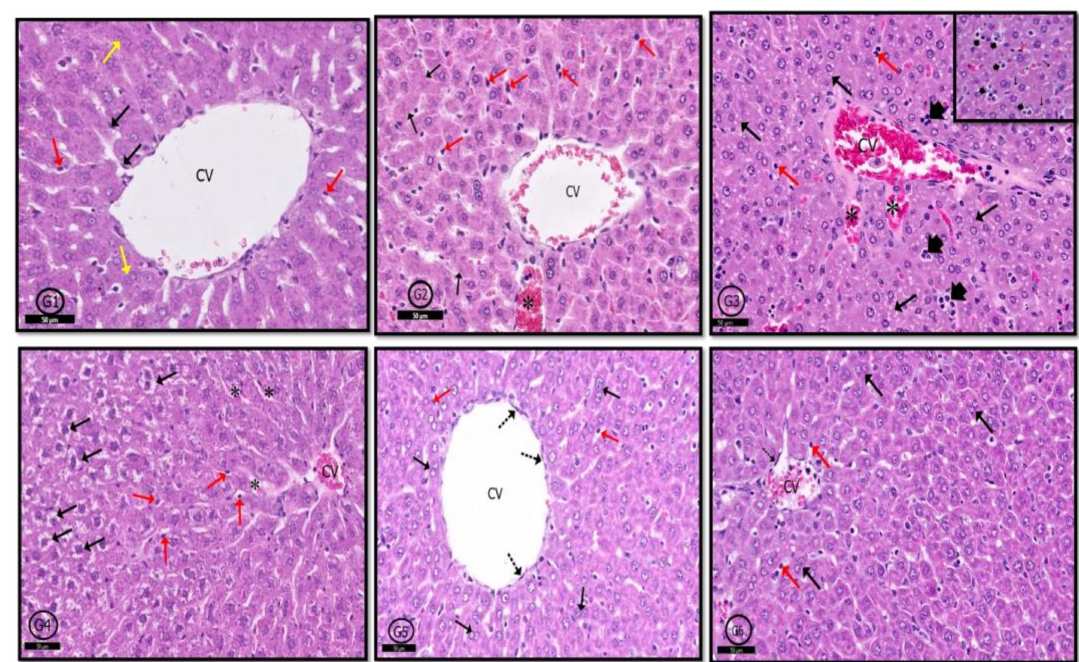
Figure 8. Photomicrographs of rat liver of different groups. In control rats ( G1 ), normal hepatic profile contains hepatocytes arranged in cords around the central vein (CV), some hepatocytes are binucleated (black ↑ ); blood sinusoids (red ↑ ) and von Kupffer cells (yellow ↑ ). In ( G2 ) (PILO rats), hepatic architecture was generally normal but few nuclei showed karyolysis (black ↑ ), congestion of some blood sinusoids (*), and few prominent von Kupffer cells (red ↑ ). In ( G3 ) (PILO+LPS rats) and ( G4 ) (PILO+LPS+VPA rats) hepatic tissue showed degenerated hepatocytes with pyknotic nuclei (black ↑ ), congested central vein (CV); focal aggregations of inflammatory cells (head arrow—inset) and increased von Kupffer cells (red ↑ ) in congested blood sinusoids (*). In ( G5 ) (PLC+LPS+Celecoxib rats) and ( G6 ) (PILO+LPS+VPA+Celecoxib rats), hepatic architecture was nearly normal showing polyhedral hepatocytes (black ↑ ), von Kupffer cells (red ↑ ) and newly formed hepatocytes (dot ↑ ). Stain; H&E. Bar 50 µ m Inset ×